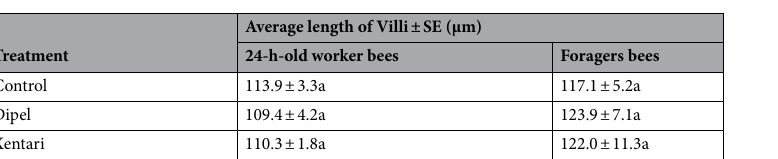
Table 2. The mean length of villi of the mesenterium [± standard error (SE)] of Apis mellifera bees after 24 h of ingestion incorporated with products. The same lowercase letters in the column indicate that there was no significant difference ( p <